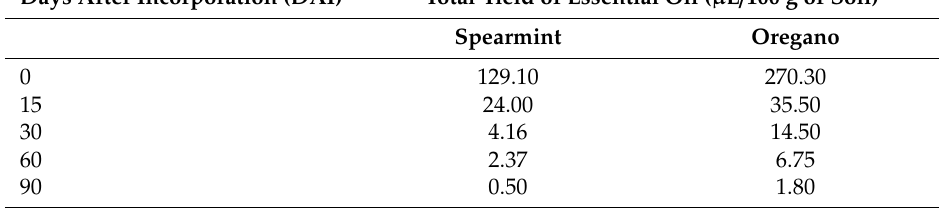
Table 2. Evolution over time of the total amounts of essential oils extracted from samples of soil amended with 4% (w / w) of spearmint or oregano tissue and kept in a glasshouse in order to accelerate the decomposition process.